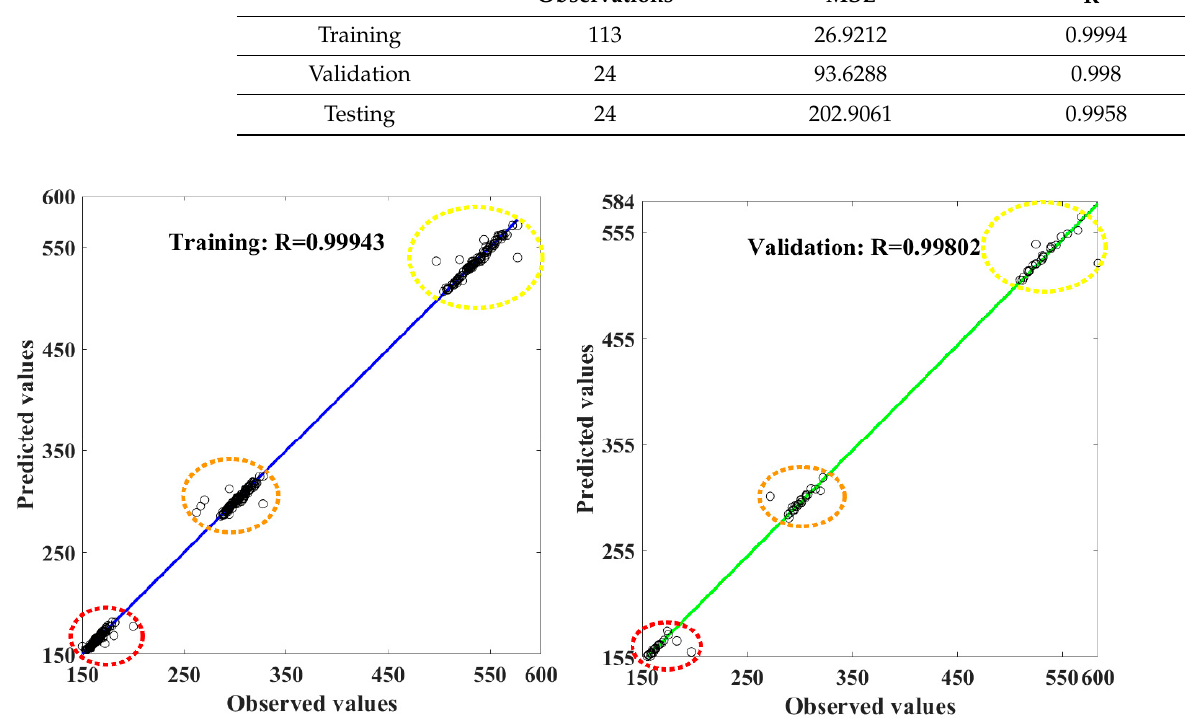
Figure 12. The correlation coefficient for three threat zone prediction values from the ANN model in training and validation in the LPG plant.